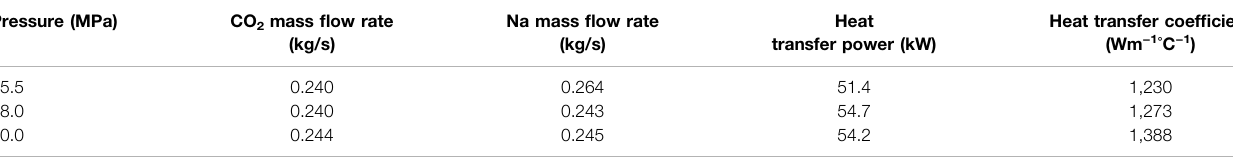
TABLE 2 | Pressure effect on the heat transfer performance.